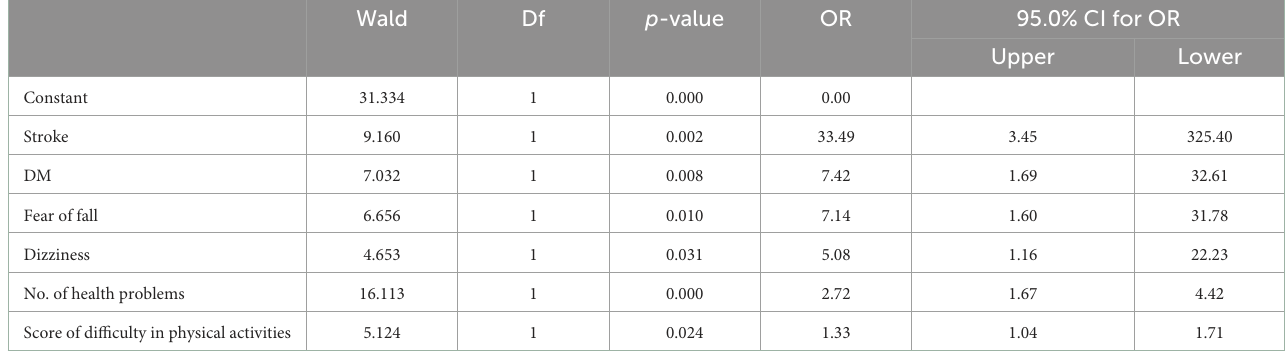
TABLE 6 Best fitting multiple logistic regression model for the occurrence of